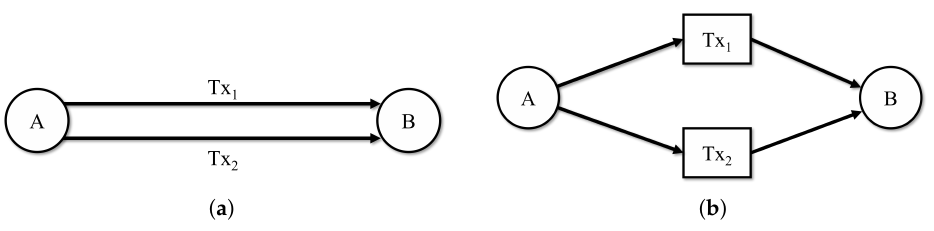
Figure 2. Graph structure of ( a ) the homogeneous transaction graph and ( b ) the proposed